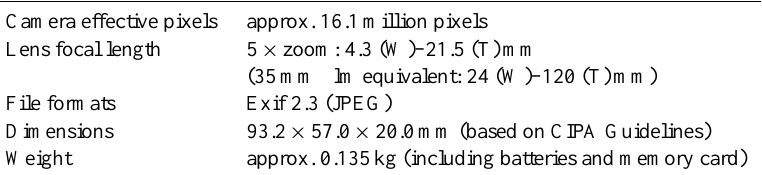
Table A2. Specifications of the Canon IXUS 127